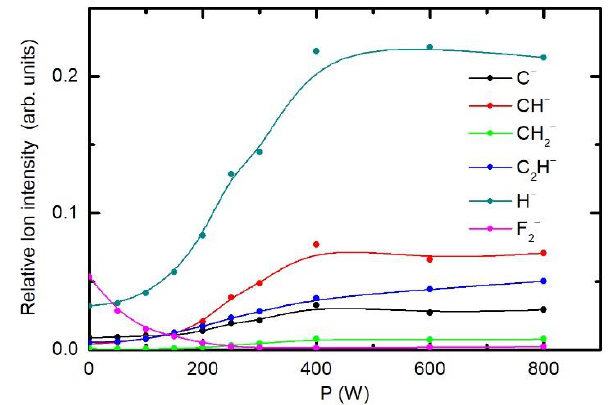
Figure 11. Variation of time-of-flight secondary ion mass spectrometry (ToF-SIMS) intensities of selected negative ions. The pressure was 25 Pa and treatment time 1 s.